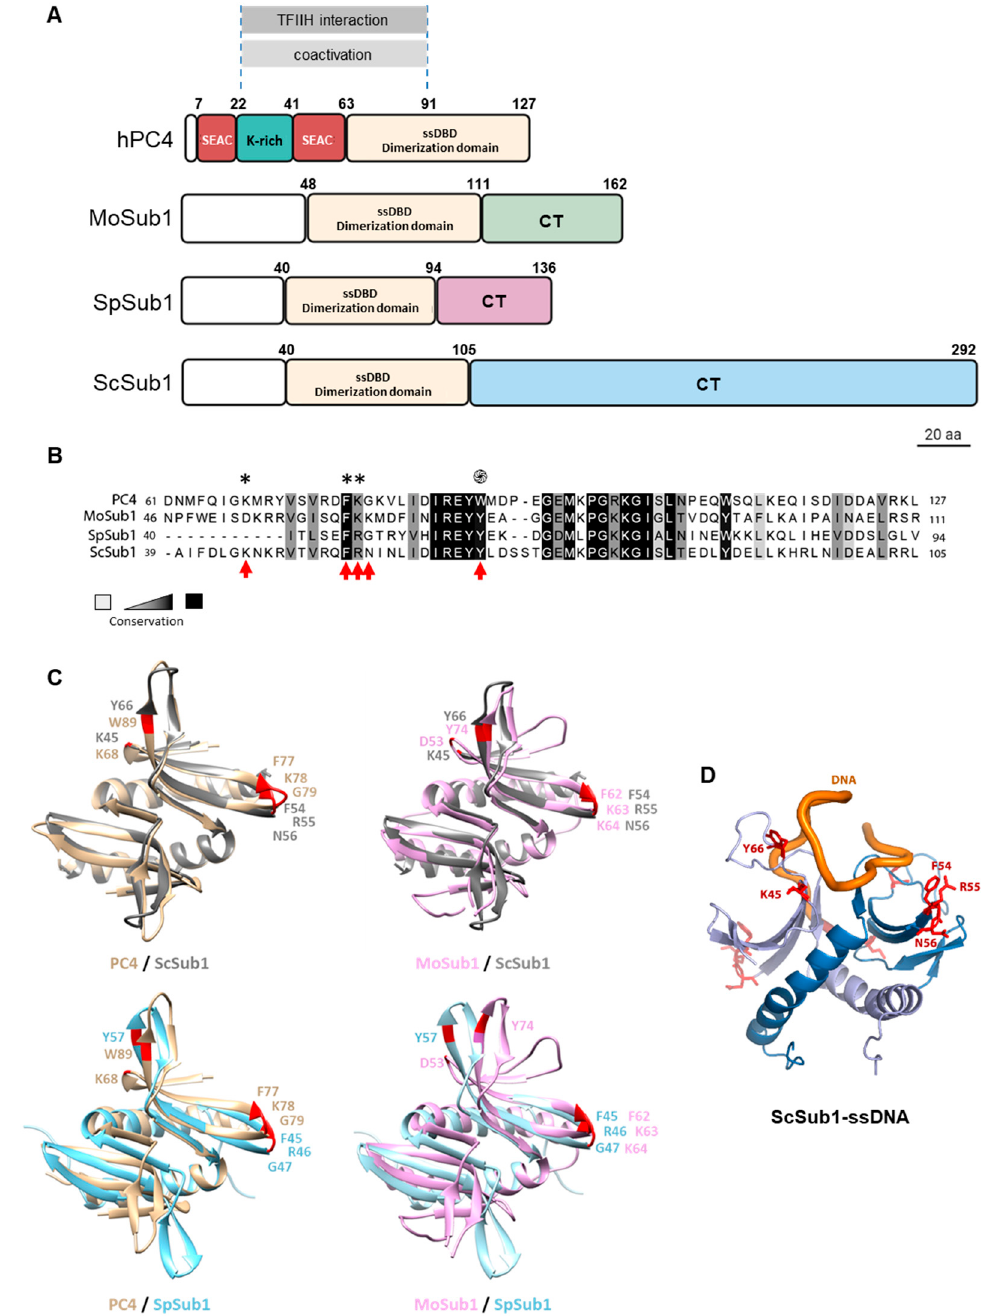
Figure 1. The DNA binding domain of Saccharomyces cerevisiae Sub1 is evolutionarily conserved. ( A ) A schematic representation of the primary structures of human PC4 (hPC4) and Sub1 orthologues from Saccharomyces cerevisiae (ScSub1), Schizosaccharomyces pombe (SpSub1), and Magnaporthe oryzae (MoSub1) showing the size and location of their structural and functional domains; hPC4 contains a lysine-rich (K-rich) region bordered by two serine and acidic residue-rich (SEAC) regions. The region for TFIIH interaction and coactivation is indicated. ( B ) Multiple sequence alignment of the ssDBD/dimerization region of hPC4/Sub1 orthologs showing the highly conserved residues; a white/black scale is shown to indicate residue conservation; thus, highly conserved residues are shown within a black background. In the case of ScSub1 ssDBD, 49% of the residues are identical and 26.9% are similar to hPC4 ssDBD amino acids. Additionally, (*) indicates the residues, the mutation of which reduces the binding of PC4 to ssDNA, and ( ֍ ) indicates W89 residues, whose muta ‐ tion causes loss of DNA binding [14]. The conserved residues that have been mutated in ScSub1 in our study are indicated by red arrows. ( C ) ScSub1 and SpSub1 ssDBD dimer structures (40–105 and